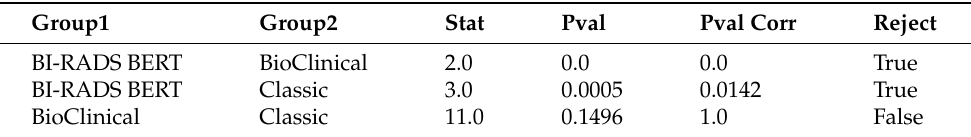
Table A18. Bonferonni-corrected McNemar test results for field extraction with no section segmenta- tion of menopausal